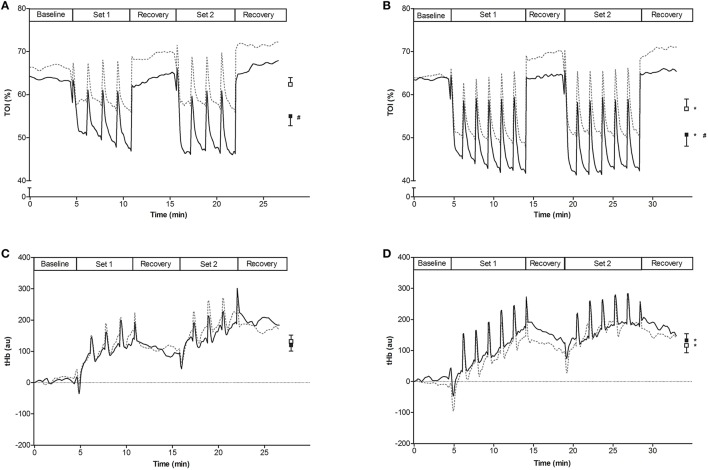
Effect of knee-extension training in normoxia vs. hypoxia on muscle oxygenation status. Curves represent mean values (n = 10) for tissue oxygenation index (TOI, A,B) and muscle total hemoglobin (tHb, C,D) measured by NIRS in subjects living for 5 weeks in normobaric hypoxia with simulated altitude gradually increasing from 2,000 to 3,250 m. Meanwhile one leg was trained in 12.3% FiO2 (TRHYP, ~4,300 m, full lines), whilst the other leg was trained in 20.9% FiO2 (TRNOR, dotted lines). The training sessions consisted of two times 4 series of 30 knee-extensions at 20% 1RM in week 1, increasing to two times 6 series of 30 knee-extensions at 25% of 1RM in week 5. Mean values ± SEM are given at the right side of each graph (TRNOR, □; TRHYP, ■). Values were measured in week 1 (A,C) and week 5 (B,D) of the training period. See Methods for further details. *P < 0.05 compared to week 1; # P < 0.05 compared to training in normoxic conditions.